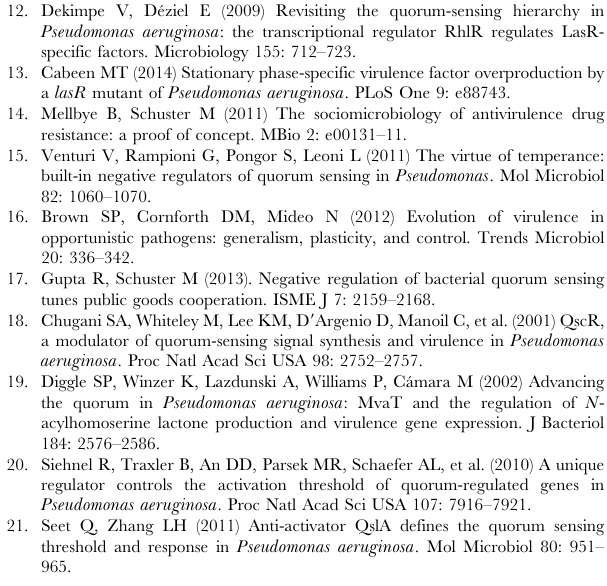
Figure S2, The presence of pBBR1MCS-5 vector does not affect virulence-related phenotypes in P. aeruginosa . Figure S3, Bacterial load in the lungs of mice infected with P. aeruginosa